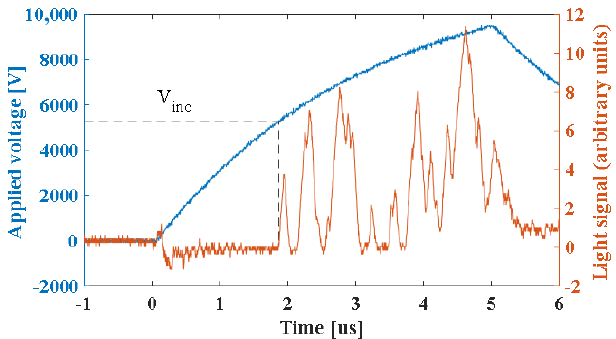
Figure 2. Typical applied voltage V R and light signal recorded as a function of time. The streamer inception voltage is also indicated.